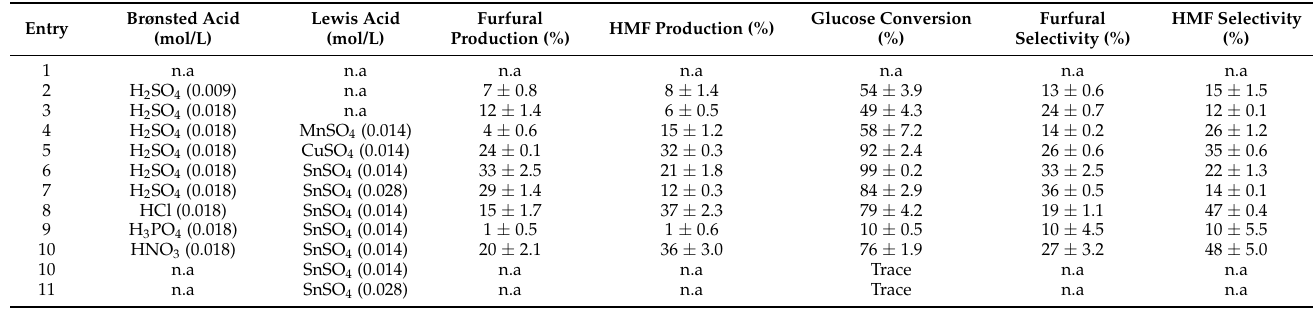
Table 1. Glucose conversion into furfural and 5-hydroxymethylfurfural (HMF) using single and mixed catalysts. Reaction